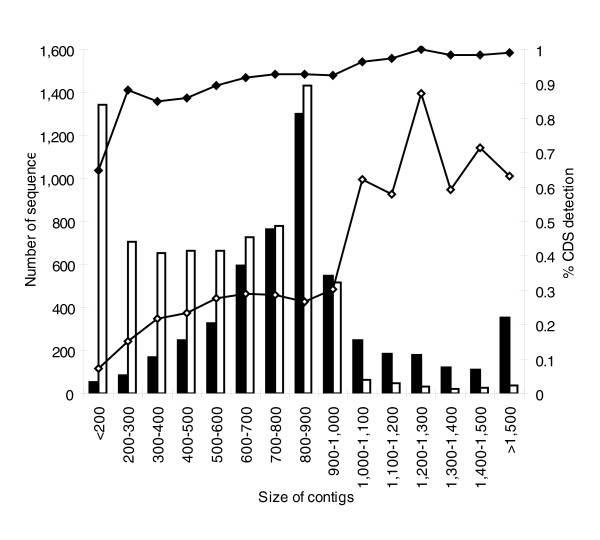
Size distribution of the 12,082 EST-derived unique transcripts from A. pisum. Contigs and singletons with (filled bars) or without (open bars) a significant hit have been selected with a cutoff value 10-5 after a BLASTX on Uniprot. Size classes (in base pairs) were binned (for sequences less than 200 bp and more than 1,500 bp) to contain a minimum of 20 sequences for both 'hits' and 'no-hits' contigs. The curves (hits, filled diamonds; no-hits, open diamonds) show the percentage of contigs for which a coding sequence was predicted by FrameD. Contigs with no predicted coding sequences are presumably entirely UTR.